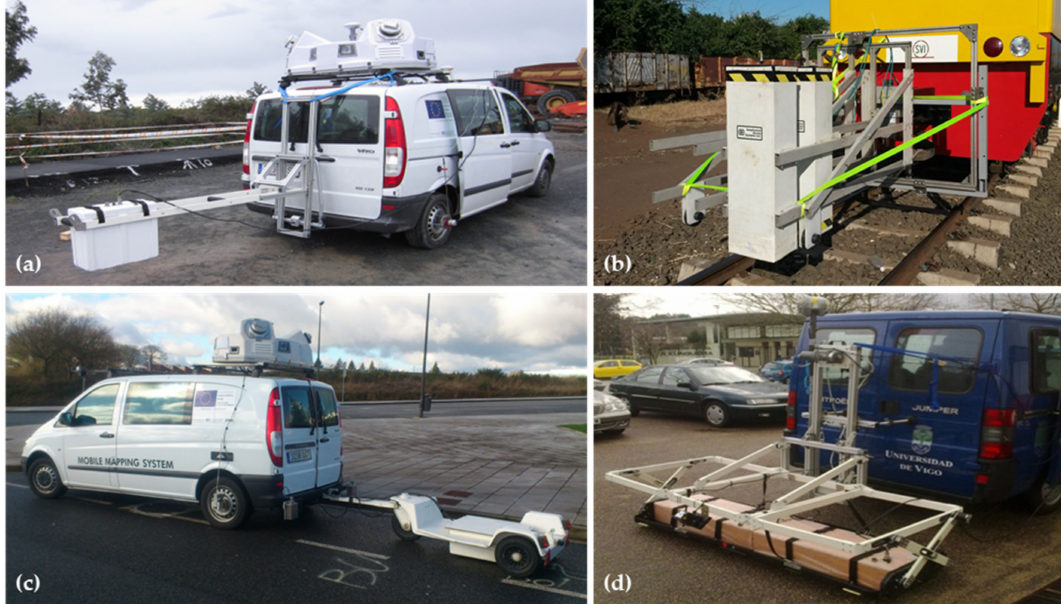
Figure 1. Different ground penetrating radar (GPR) antennas: ( a ) air-coupled (horn) antennas, ( b ) multi-antenna system (horn), ( c ) ground-coupled (dipole) antennas in a trolley, and ( d ) array multi-channel (ground-coupled)